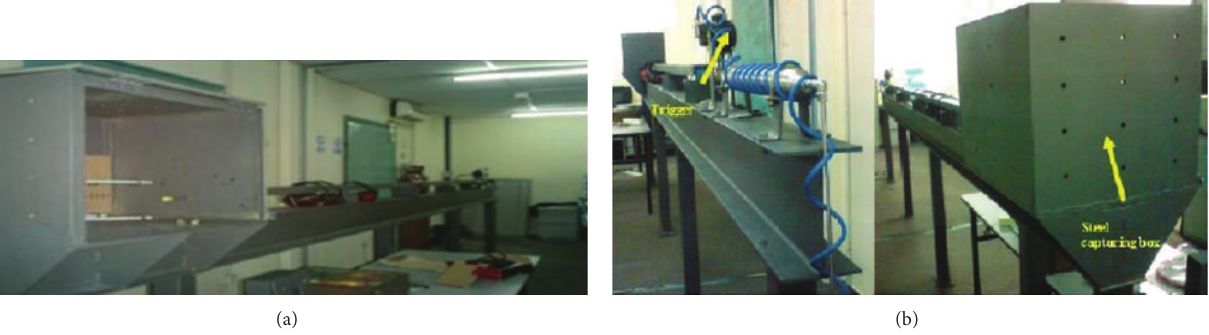
Figure 2: (a) Gun equipment [9] and (b) gas gun